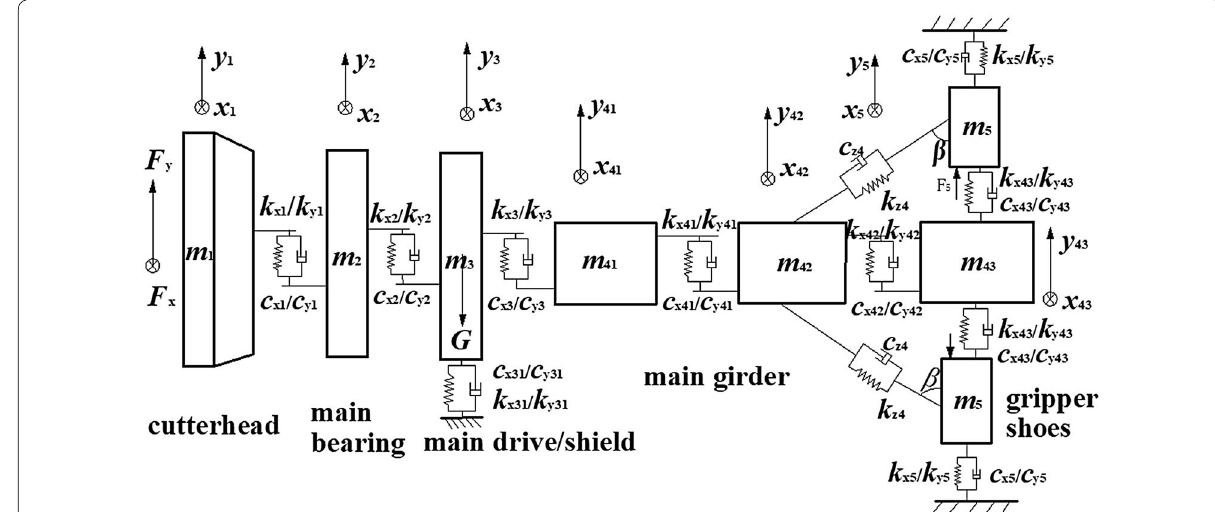
Figure 2 Dynamic model of the lateral and vertical vibrations of the TBM mainframe